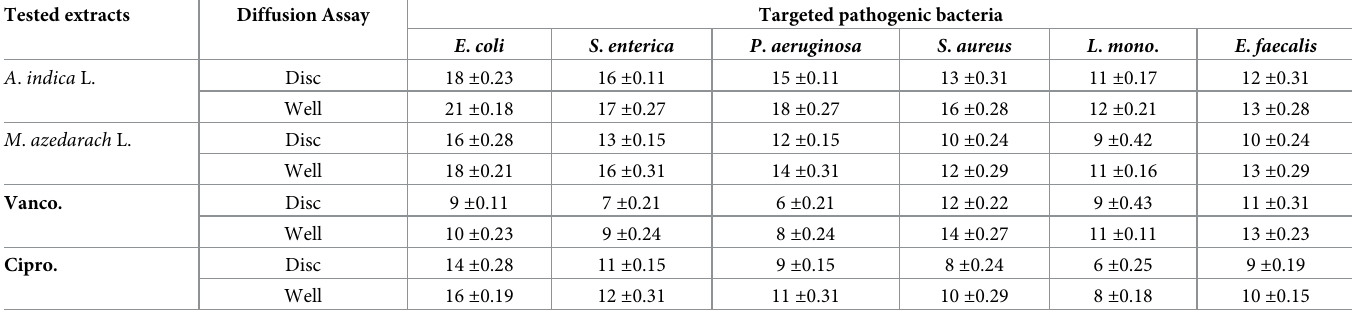
Table 3. Antibacterial activity and zone of inhibition (diameter in mm) of the tested plant leaves extracts of A . indica L. and M . azedarach L. against selected Gram- negative and Gram-positive bacteria. Tested